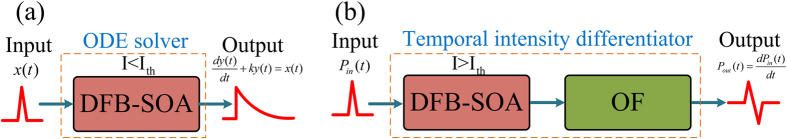
Schematic diagram of the analog optical signal processor.(a) The proposed analog optical signal processor is configured as a photonic ODE solver. (b) The proposed analog optical signal processor is configured as a photonic temporal intensity differentiator.